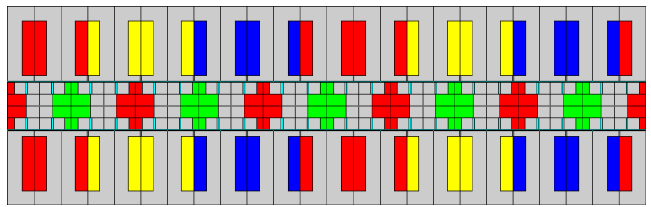
Figure 2. 2D view of the TLST axial flux interior permanent magnet (AFIPM) machine with flux barriers (2D finite element method (FEM) simulation model).